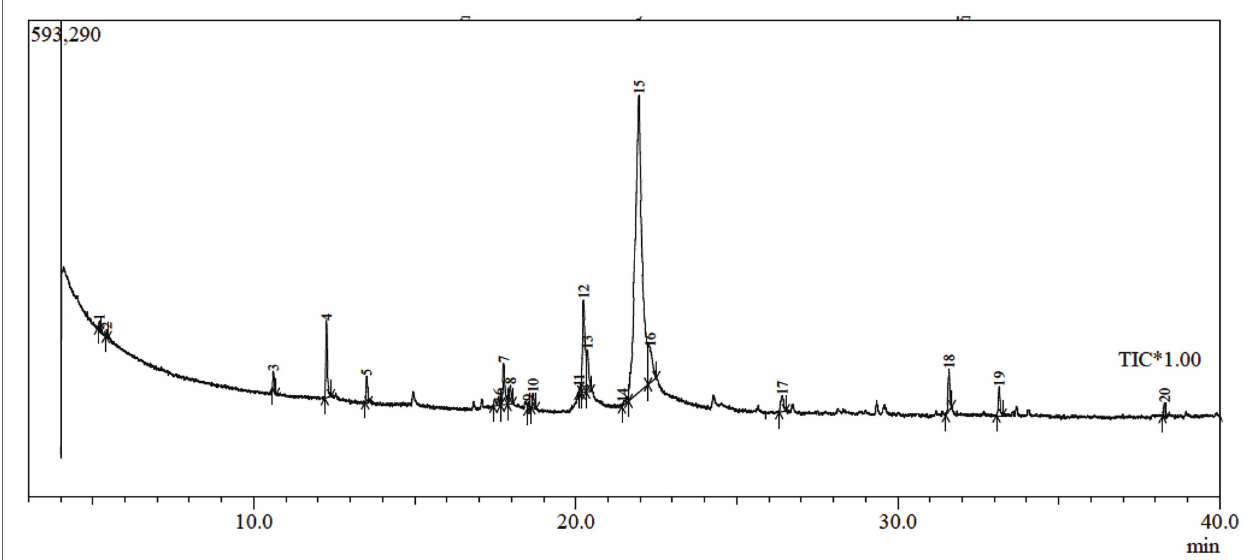
FIGURE 7 | GC-MS chromatogram of fermented peanut plant residual (PNR) by the endophytic Trichoderma sp. WKA55, displaying the peaks of various components.